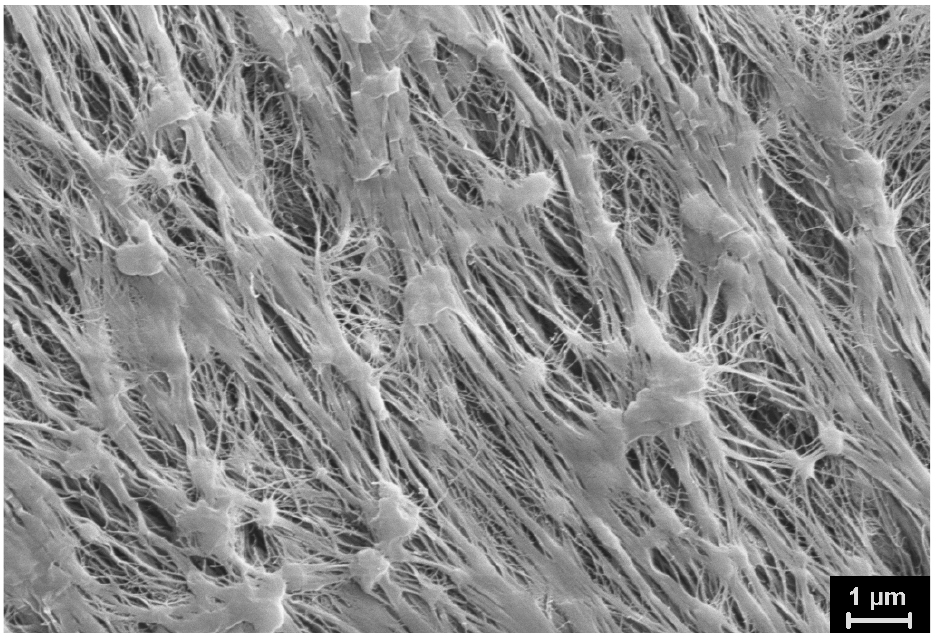
Figure 15. SEM micrograph of Lupolen reactor powder.